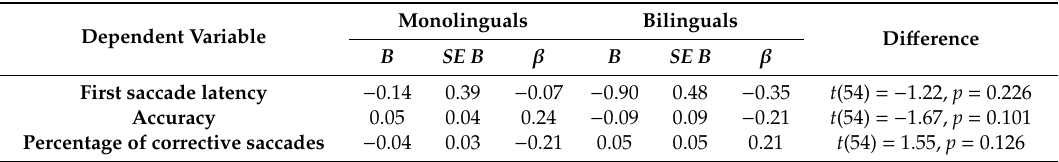
Table A1. Regression coe ffi cients and t-statistics of the relationship between trait anxiety and the dependent variables (prosaccade trial performance).